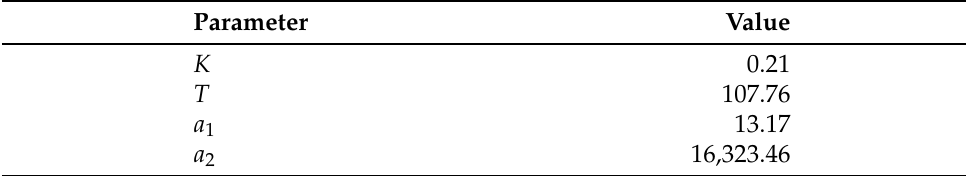
Table 1. Model parameters.